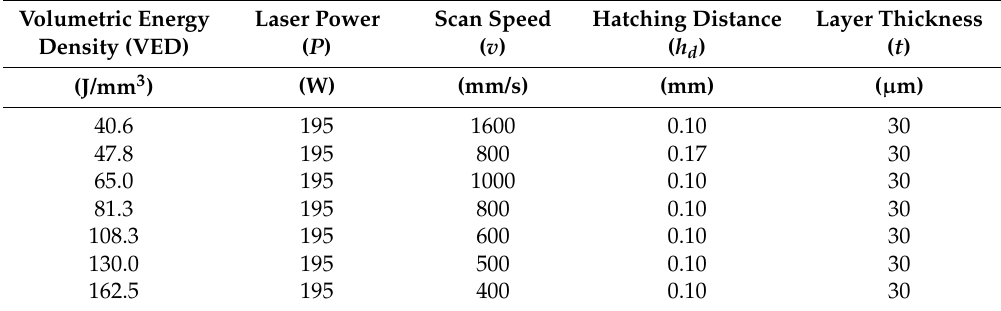
Table 1. LPBF (laser powder bed fusion) process parameters used for the fabrication of AlSi10Mg alloy and nanocomposite